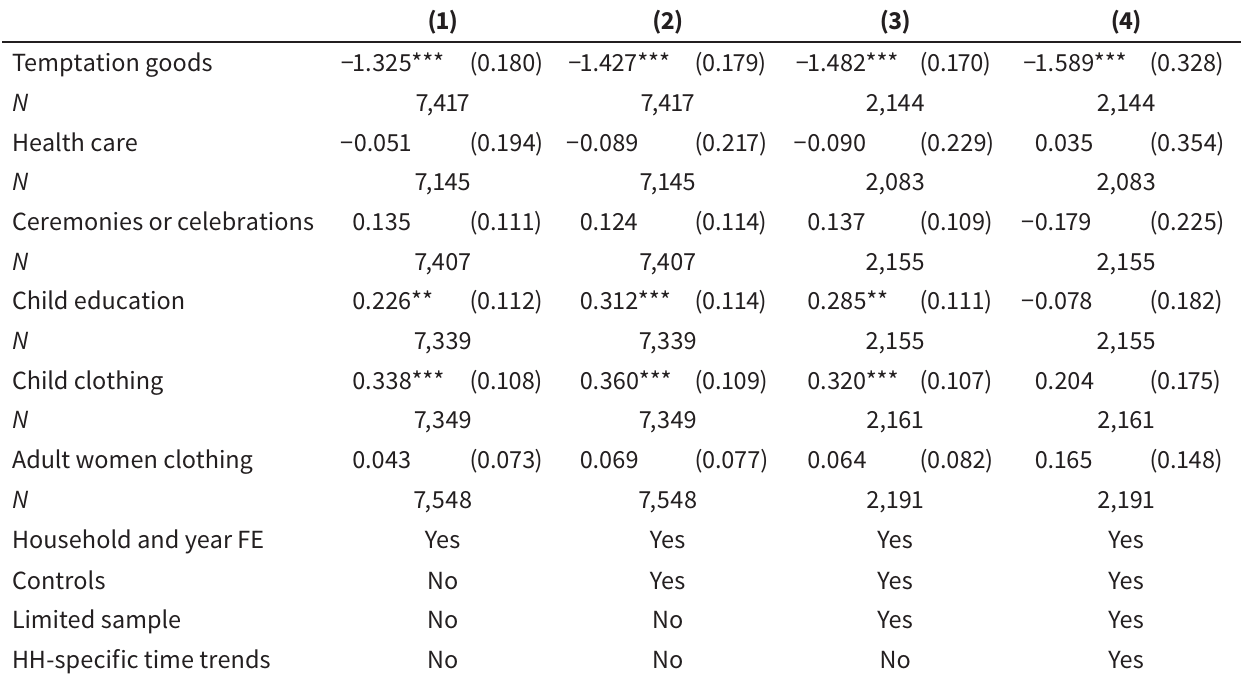
Shifts in expenditures ( asinh ) as the husband’s migrant status changes – only considering migration spells outside of Nepal and lasting >6